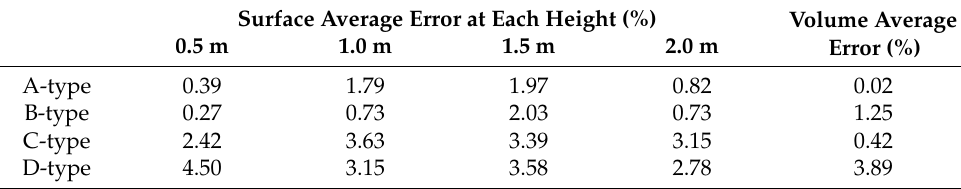
Table 6. Validation result for average velocity.